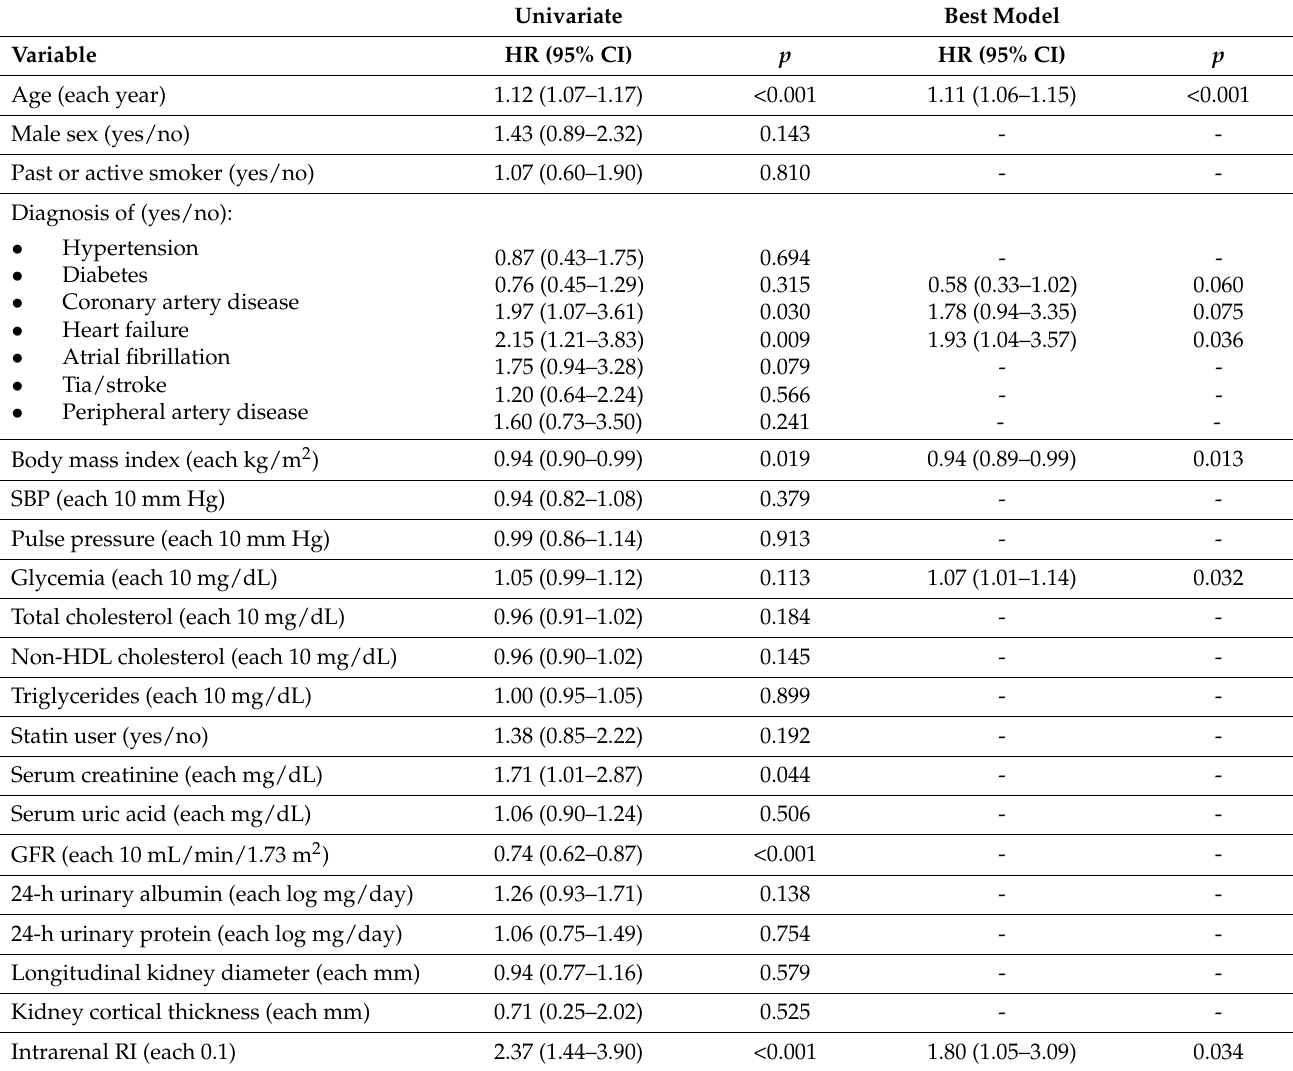
Table 5. Univariate and best Cox proportional hazards regression model for all-cause mortality.